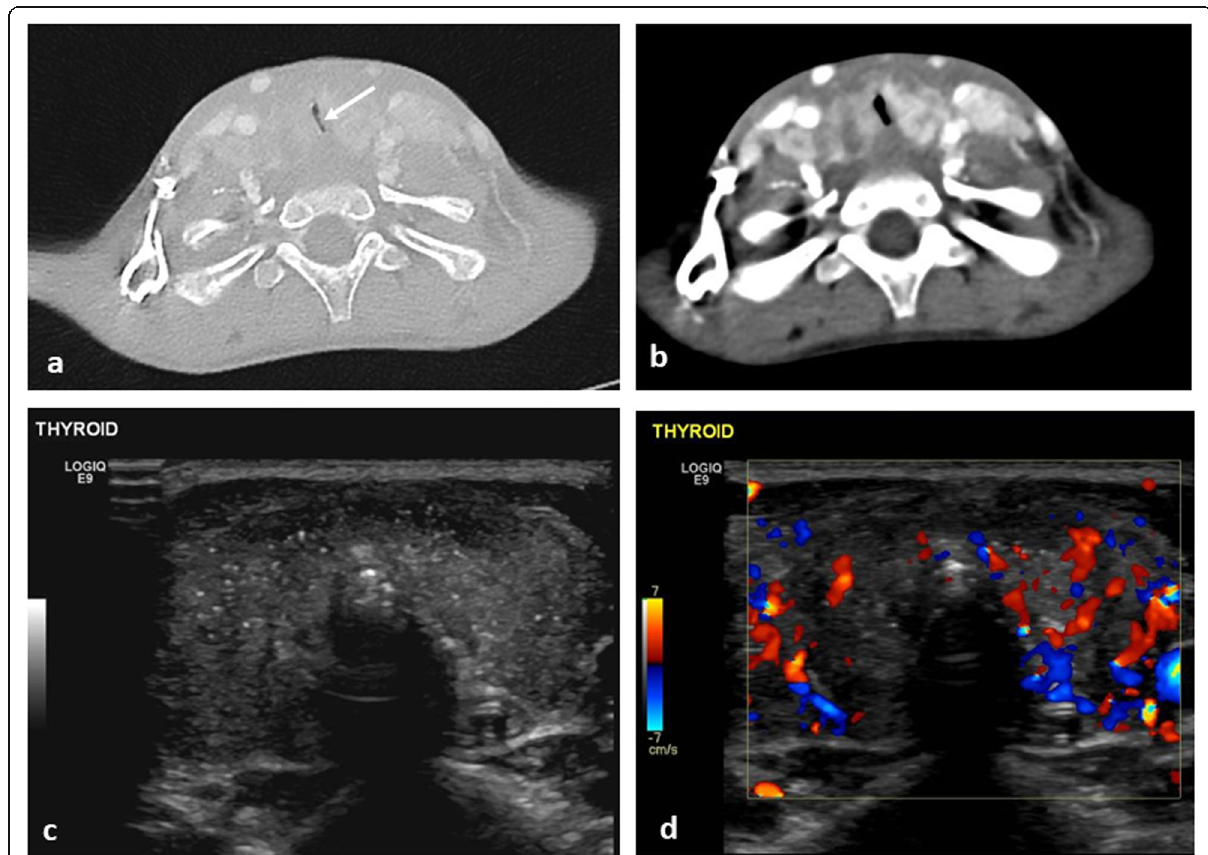
Fig. 6 A 5-year-old boy with worsening stridor, dry cough and cervical lymphadenopathy with papillary thyroid carcinoma. a Axial CT of the neck (lung windows) demonstrates marked narrowing of the trachea, with slit-like appearance (arrow). b On the mediastinal windows, the thyroid gland is bulky and demonstrates patchy heterogenous enhancement. c Transverse ultrasound image of the thyroid gland prior to biopsy reveals multiple internal foci of calcification and ( d ) colour Doppler imaging reveals a hyper vascular thyroid